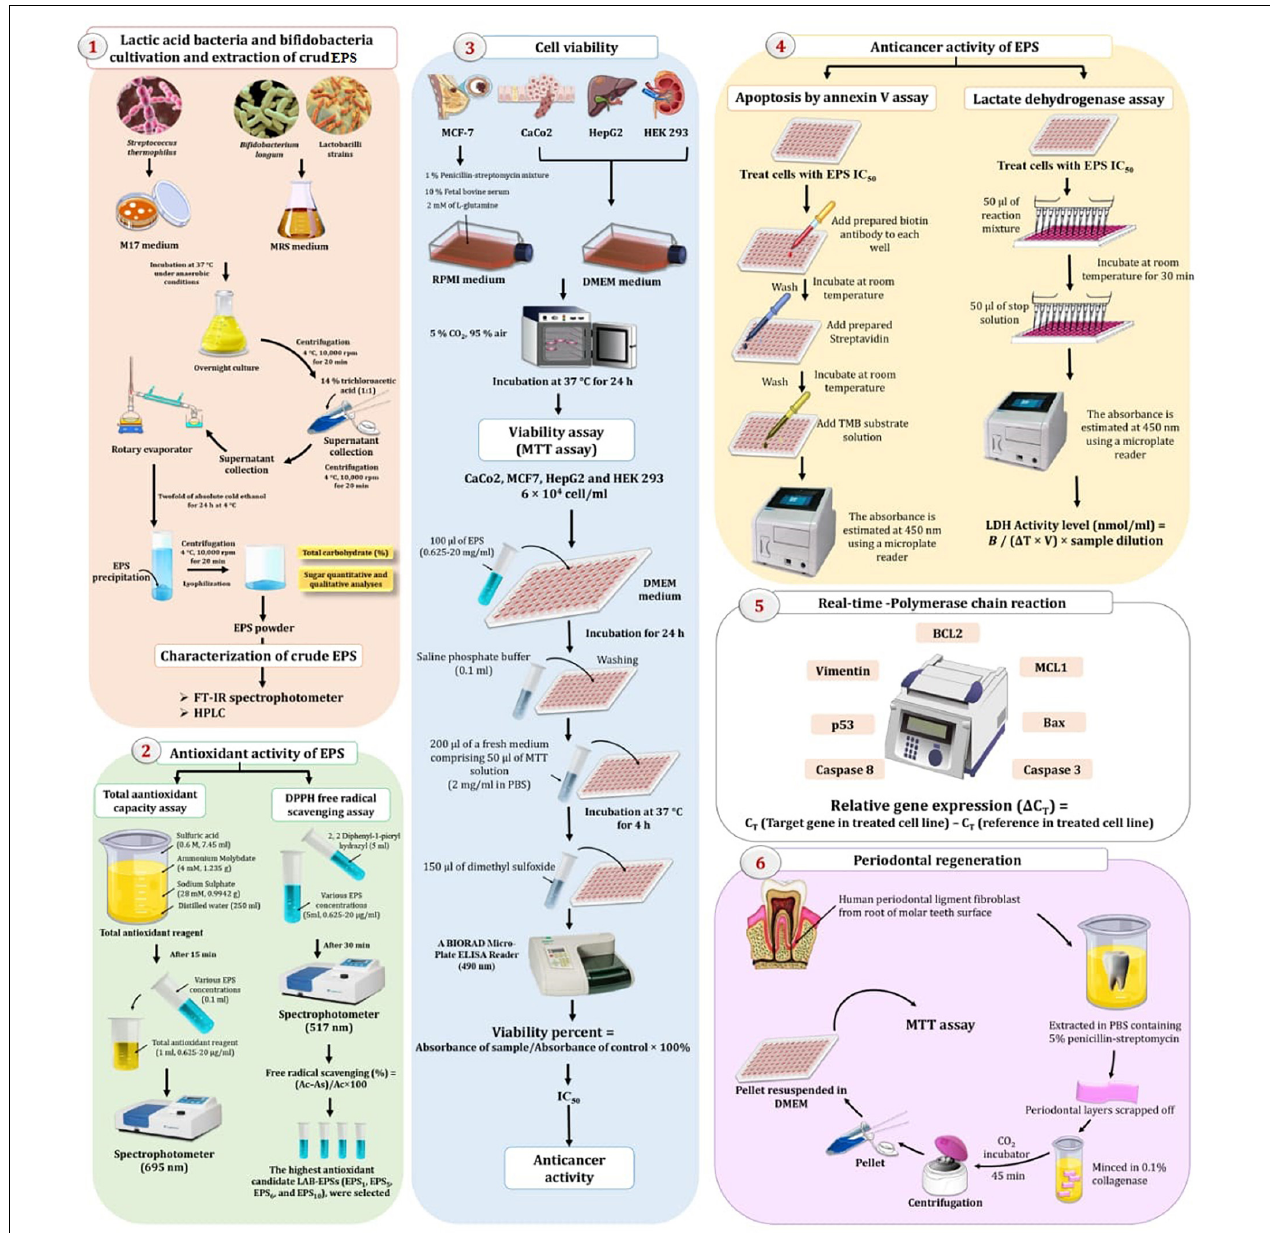
Figure 1 | Experimental setup for extraction and characterization of exopolysaccharides (EPS) by lactic acid bacteria (LAB) and bifidobacteria (Bb) exploring their therapeutic